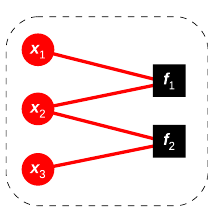
Figure 1: An illustrative example of simple factor graph with three variables x 1 , x 2 , x 3 and two function nodes f 1 ( x 1 , x 2 ) and f 2 ( x 2 , x 3 ) .